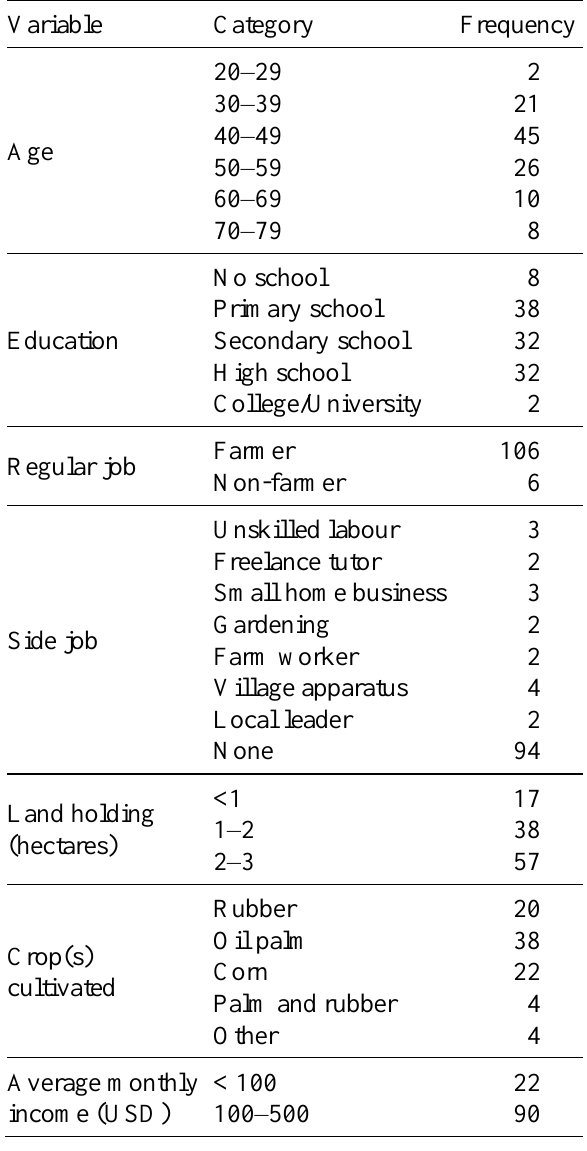
Table 2. Demographic data of